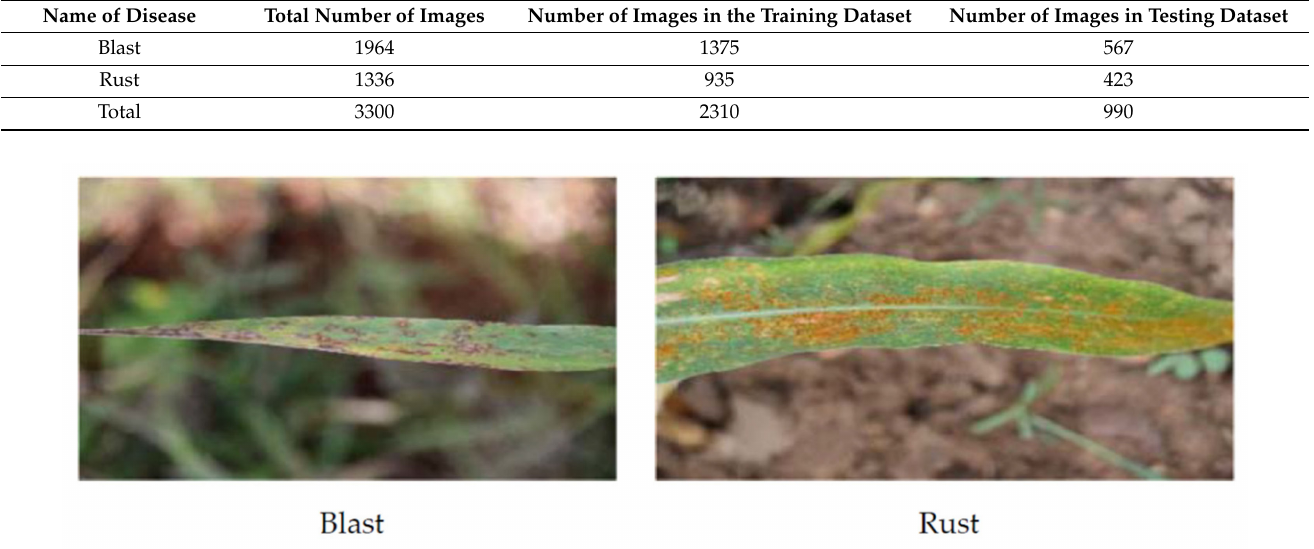
Figure 3. Sample images of pearl millet infected with blast and rust.